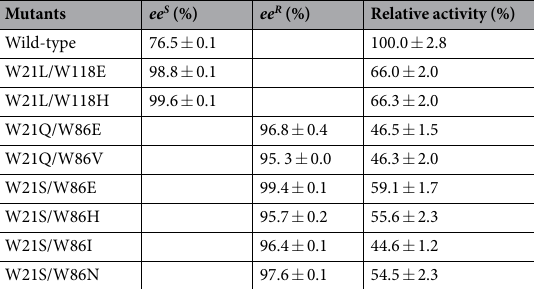
Mutants ee S (%) ee R (%) Relative activity (%)